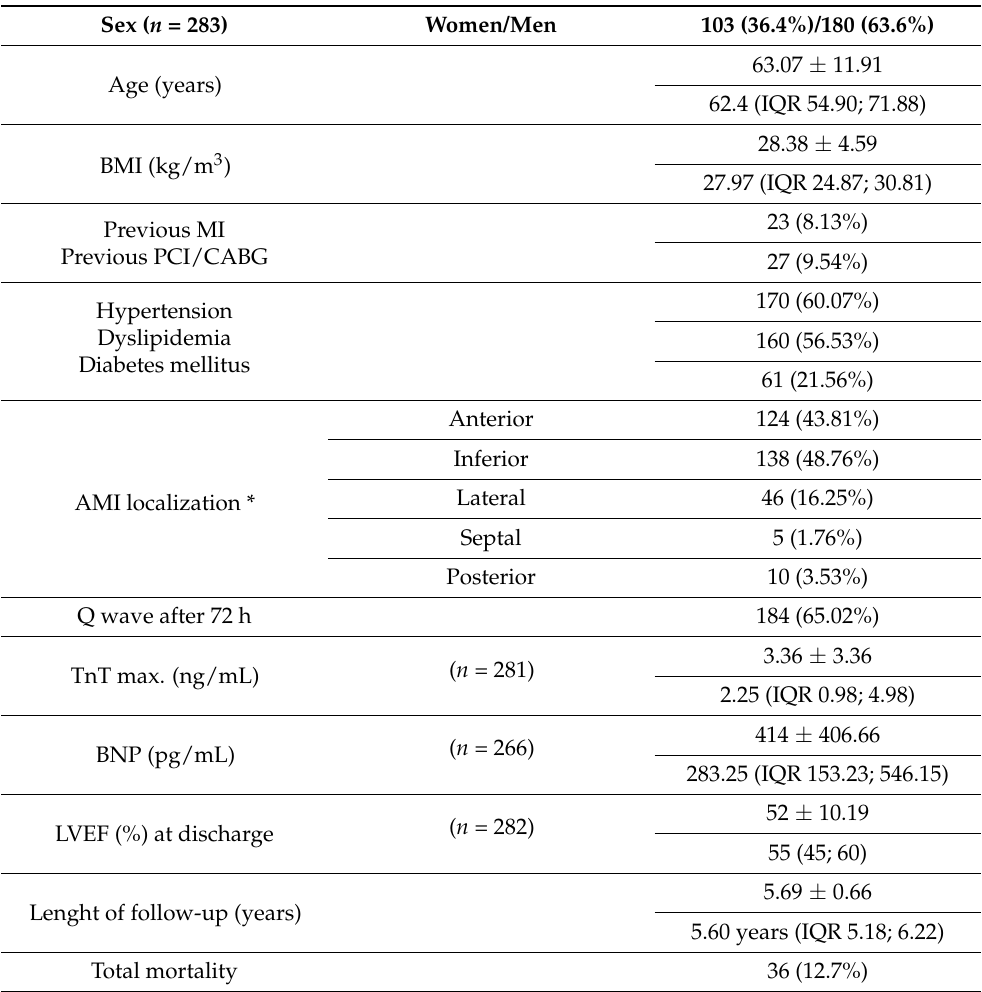
Table 1. Population characteristics ( n = 283).